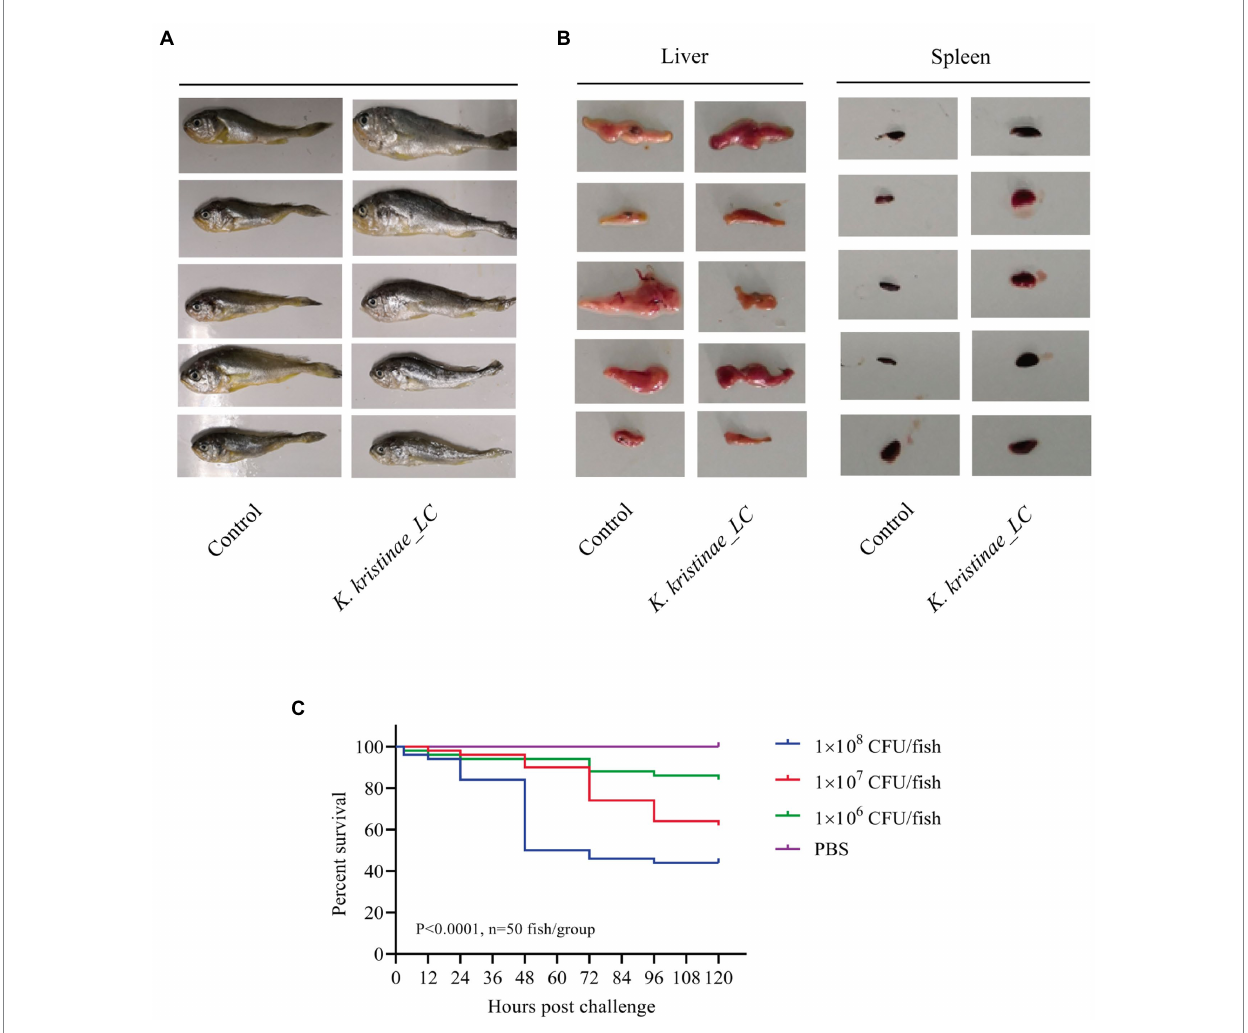
FIGURE 6 Pathological observation in large yellow croaker infected with K. kristinae_LC . The infected fish did not show manifestations on the body (A) but showed hemorrhage and swelling in the liver and spleen. Photographs of large yellow croaker organs in the regressive infection experiment (B) . Fish were infected intraperitoneally with 2 × 10 8 CFU, 2 × 10 7 CFU, or 2 × 10 6 CFU of K. kristinae_LC . The survival percentage was recorded for 120 h (C) , and significance was assessed by the log-rank Mantel–Cox test ( p value indicated on the graph; n = 50 fish per